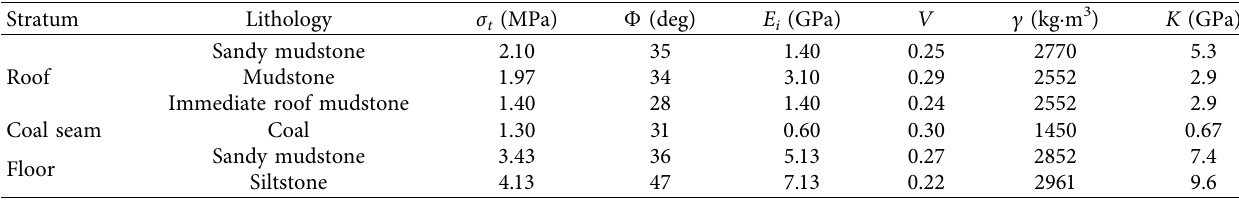
Table 1: Rock mass properties.